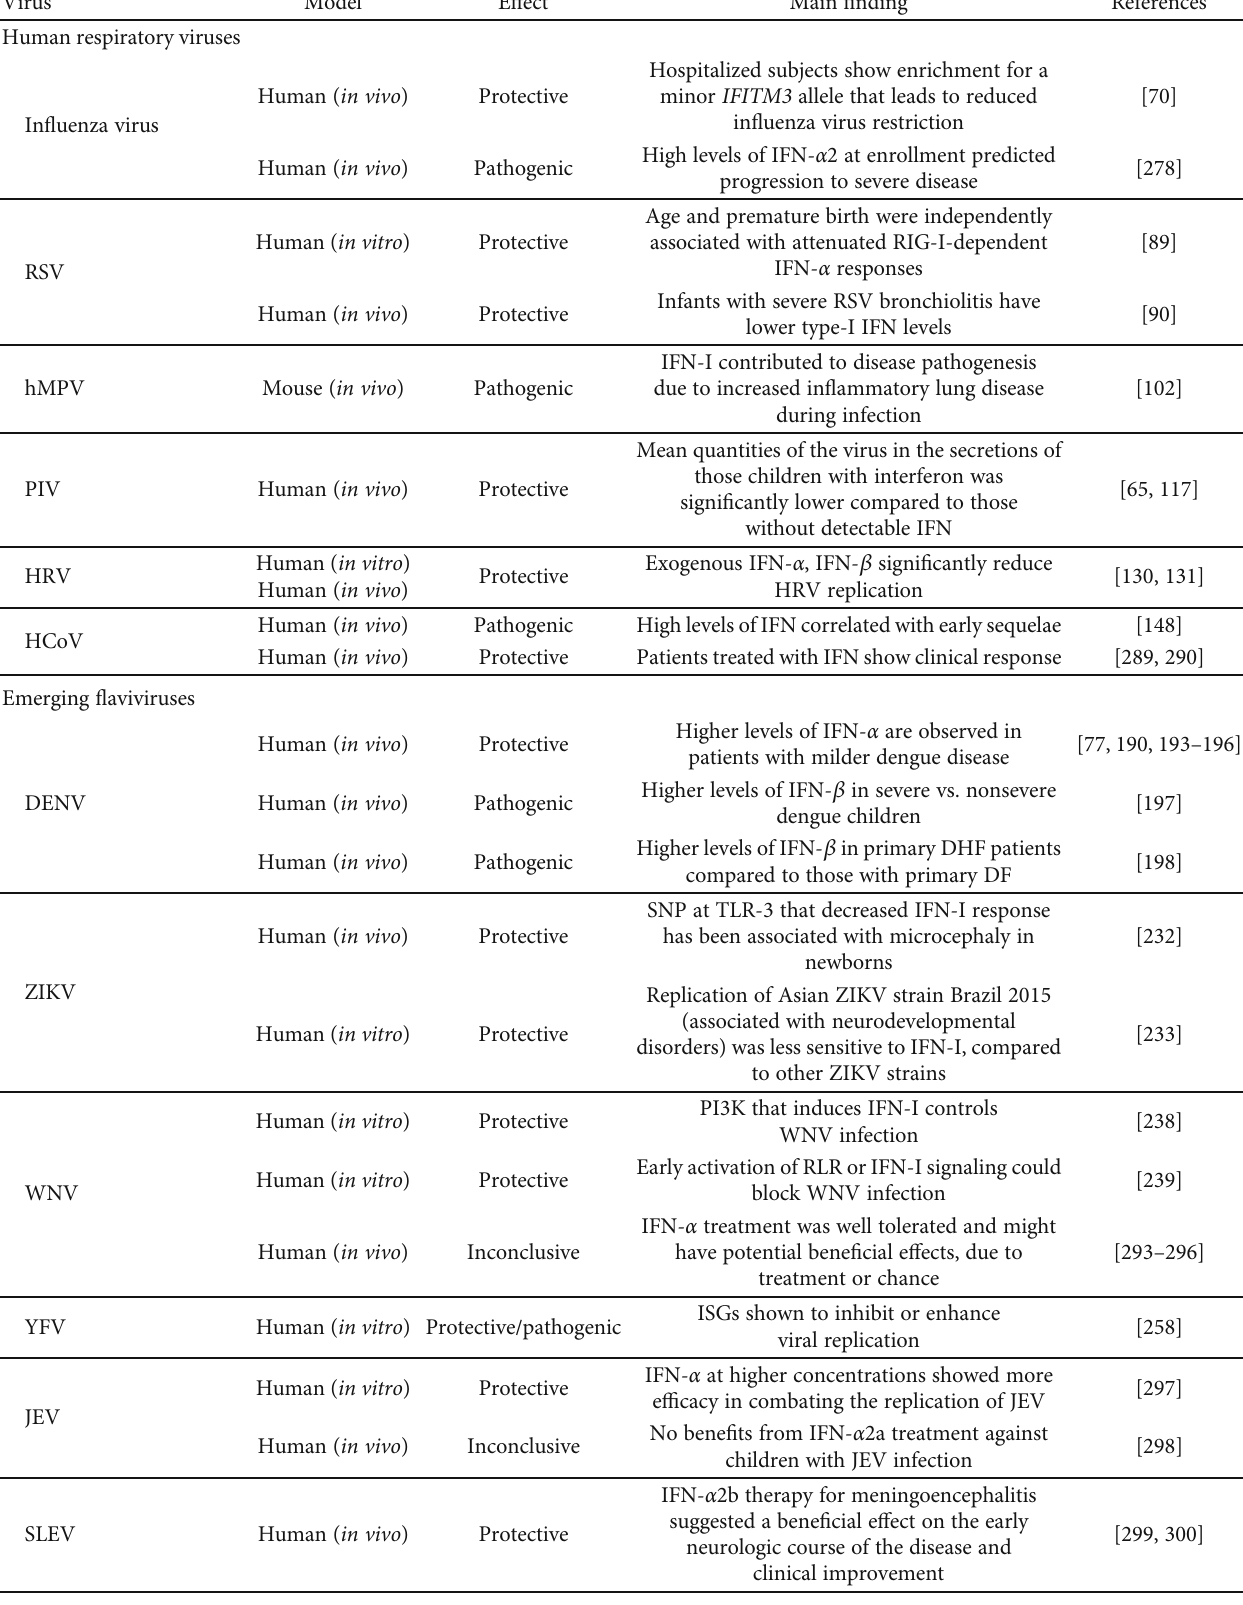
Table 1: Role of IFN-I in respiratory virus and fl avivirus